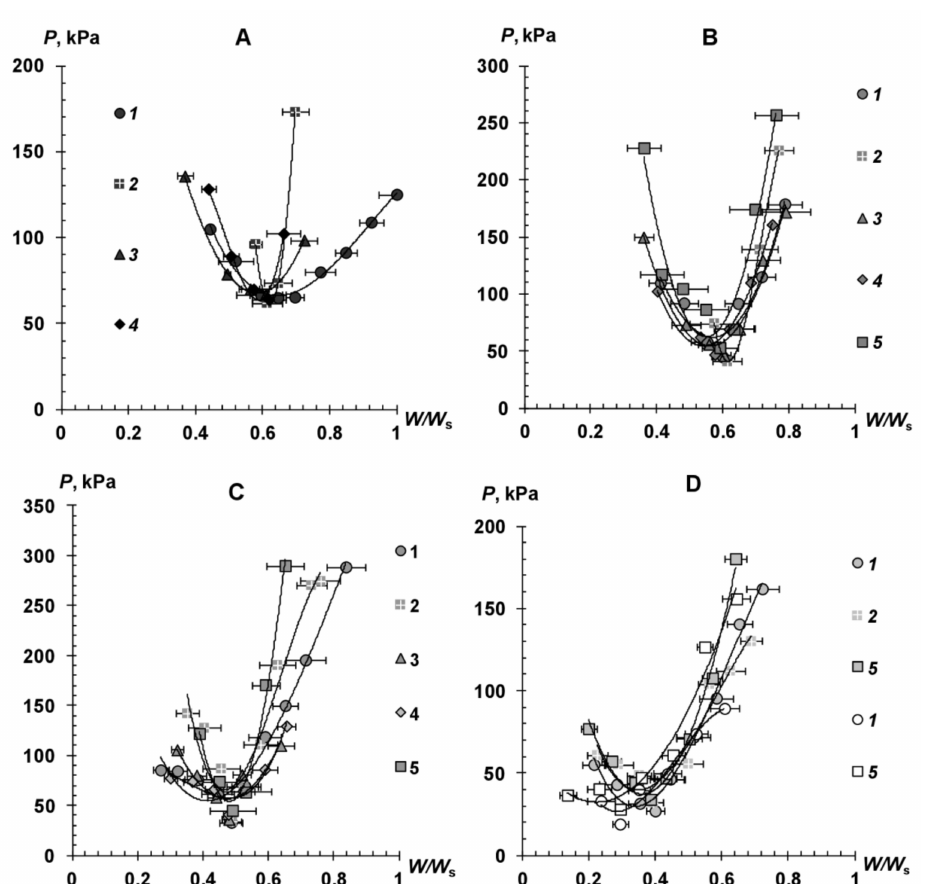
Figure 6. Soil resistivity to tillage ( P , kPa) depending on relative water content ( W / W s ) for different texture classes of Eurasian arable soils (author’s processing of experimental data [40]). Soil texture classes: ( A ) Cl, ( B ) SiL, ClL, ( C ) L, SaClL, ( D ) LSa, SaL (the intensity of symbols color falls from clays (black) to loamy sands (colorless)); Soil types: 1 -Podzols, Luvisols, 2 -Chernozems, 3 -Kastanozems, 4 -Alisols, 5 -Phaeozems,